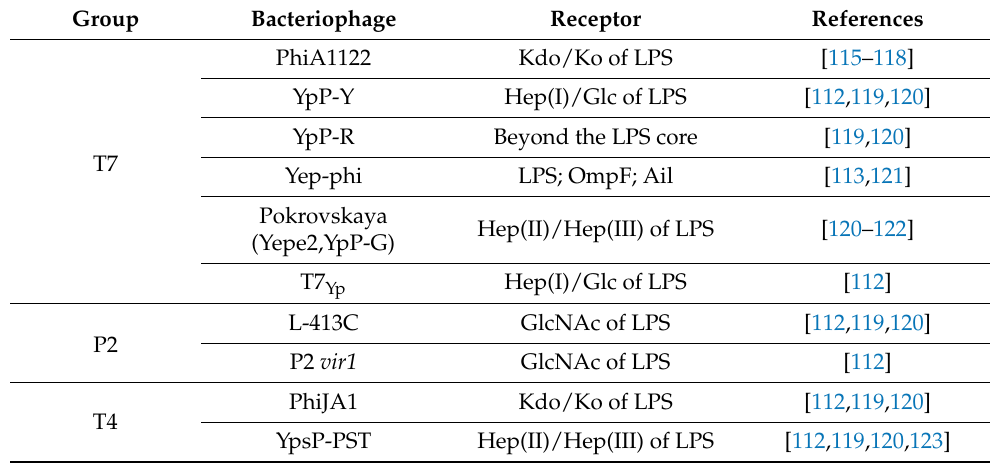
Table 5. Components of the Y. pestis LPS as a specific receptor for bacteriophages.